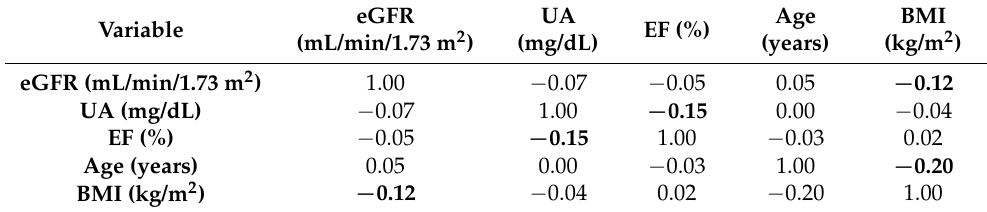
Table 2. Results of the correlation analysis for the entire study population. eGFR Variable (mL/min/1.73 m 2 ) eGFR (mL/min/1.73 m 2 )